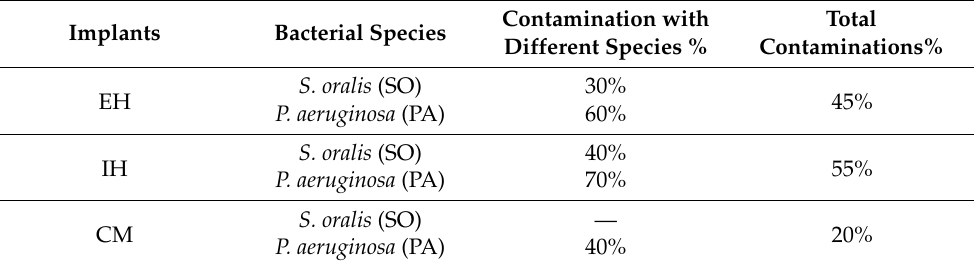
Table 1. Bacterial leakage in implants with different implant-abutment connections inoculated with